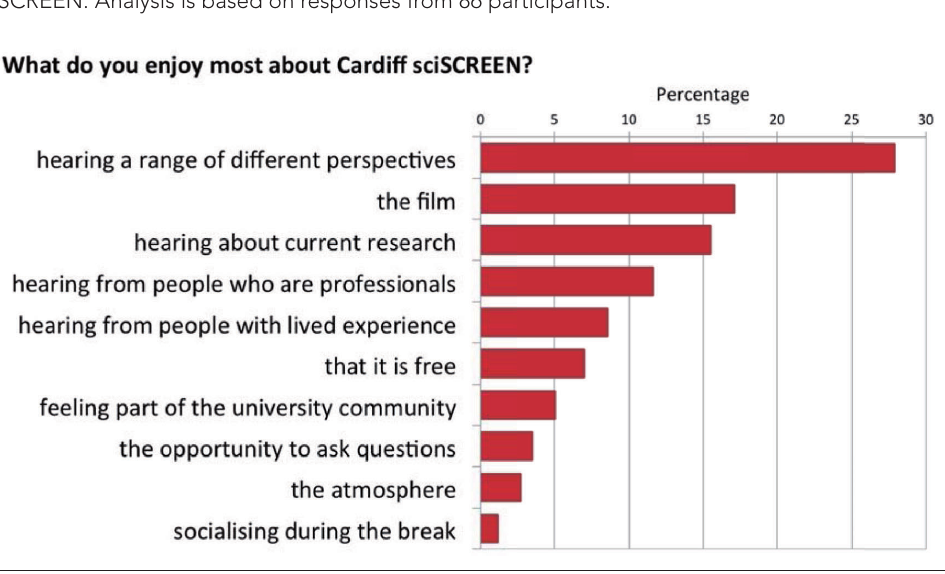
Figure 3: Response to participant survey Attendees were invited to complete a short survey regarding their experiences of Cardiff sciSCREEN events. Participants were asked to choose their top three most enjoyable aspects of Cardiff sciSCREEN. Analysis is based on responses from 86